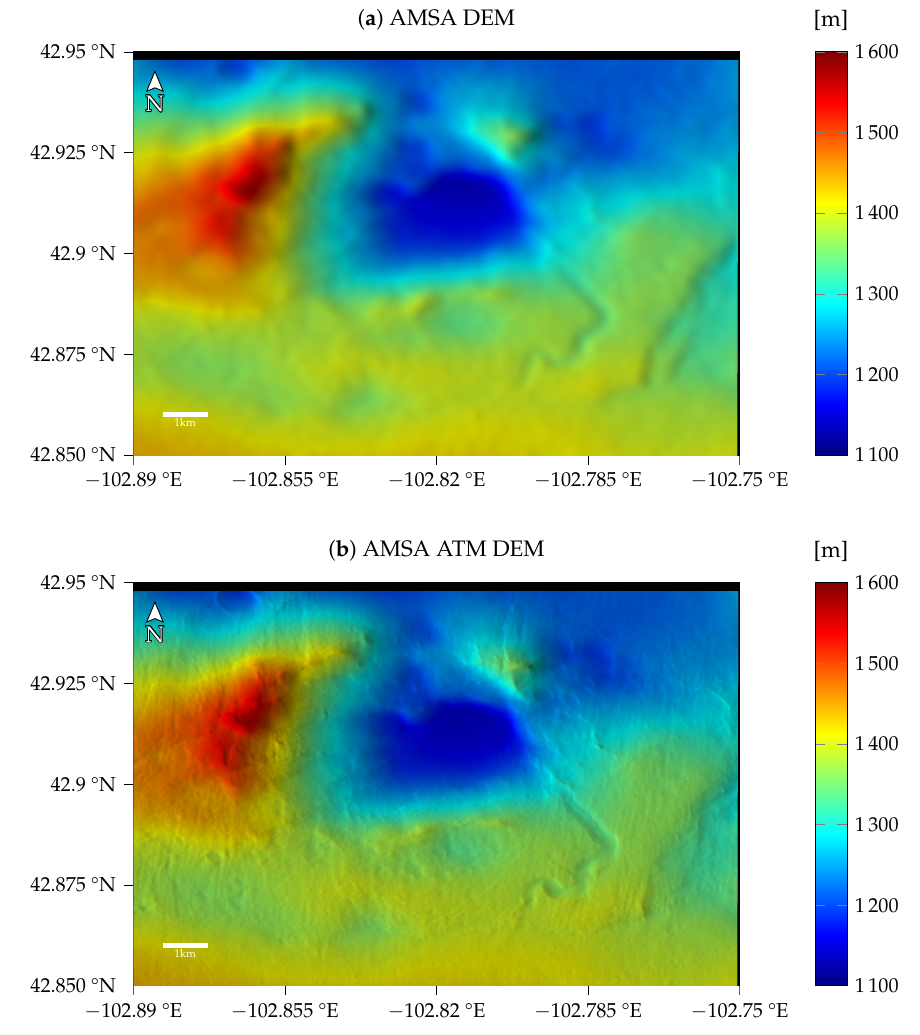
Figure 14. Results for image K13_058475_2232_XN_43N103W ( a ) without and ( b ) with atmospheric compensation. The results for γ = 3 10 − 4 and, in the case of atmospheric compensation, τ = 0.59 × are